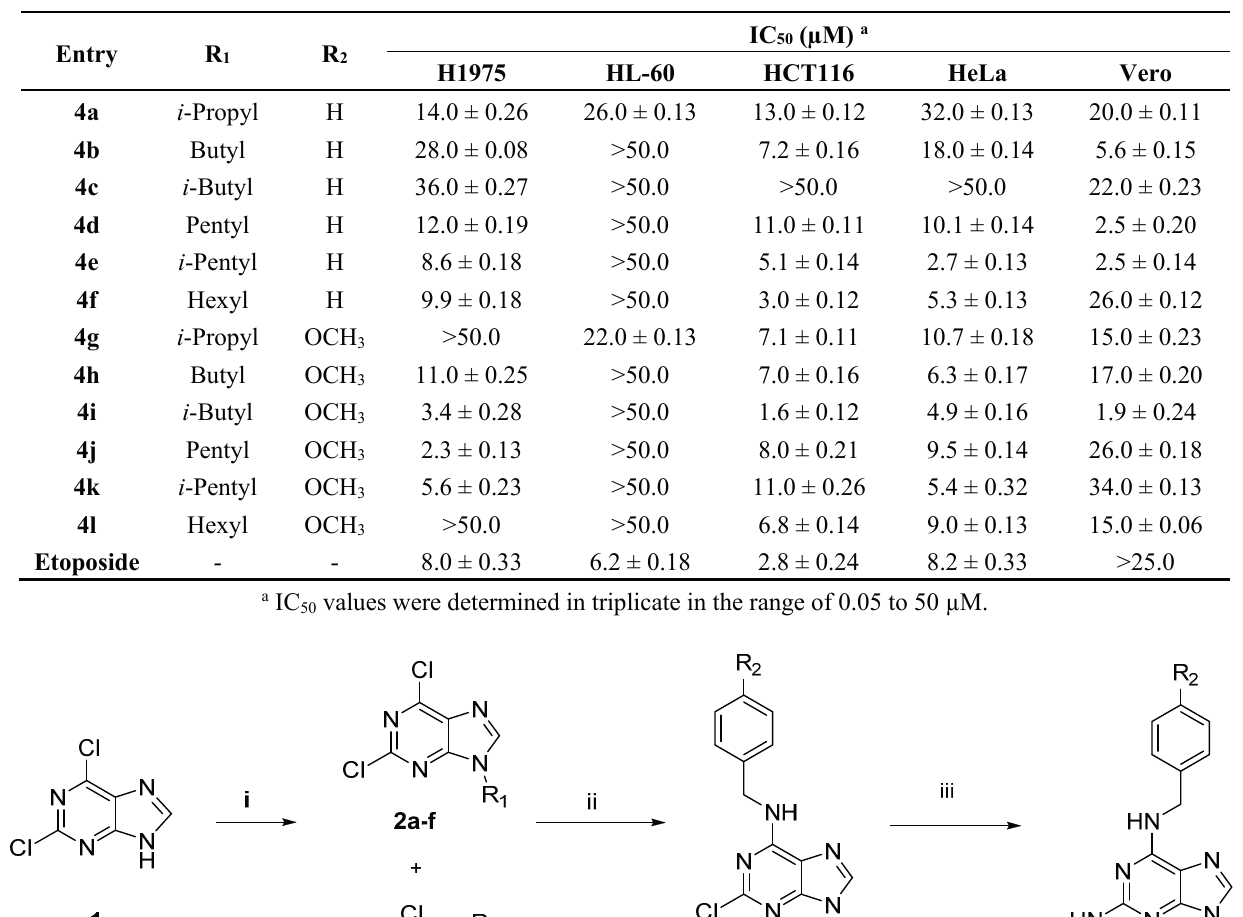
Table 1. In vitro cytotoxicity of compounds 4a – 4l on cancer cell lines and Vero cells.